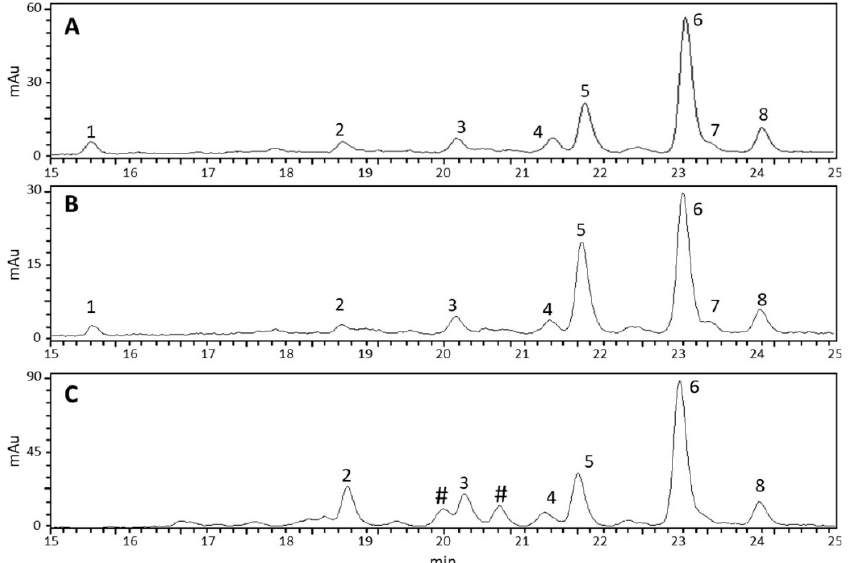
Figure 9. HPLC chromatograms (DAD λ 450 nm) showing carotenoids in healthy Lima bean leaves ( A ), TSSM-infested Lima bean leaves ( B ), and TSSMs ( C ). Numbers correspond to Lutein (1); unidentified carotenoid#1 (2); 15-cis- β -carotene (3); 13-cis- β -carotene (4); trans- α -carotene (5); trans- β -carotene (6); cis- α -carotene (7); 9-cis- β -carotene (8); γ -carotene (not shown). The symbol # indicates peaks resulting from Pheo a' and Pheo contamination (see Figure 8C). UV/Vis spectra of the nine compounds are shown in Supplementary Figure S2.